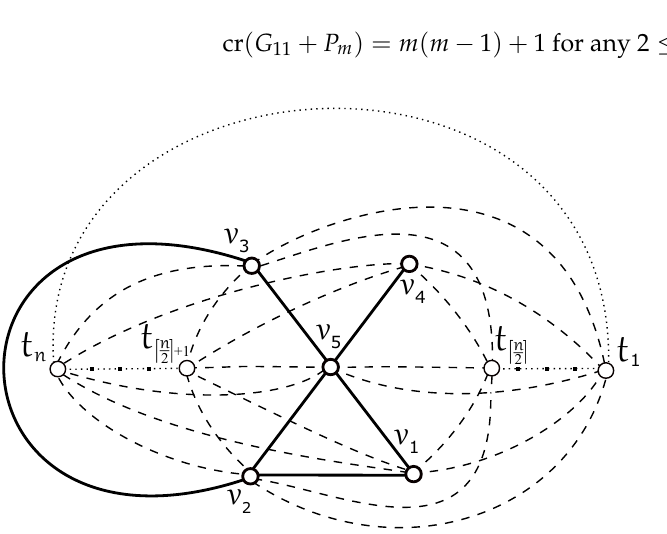
Figure 3. The good drawing of G 11 + P n with n ( n − 1 ) + 1